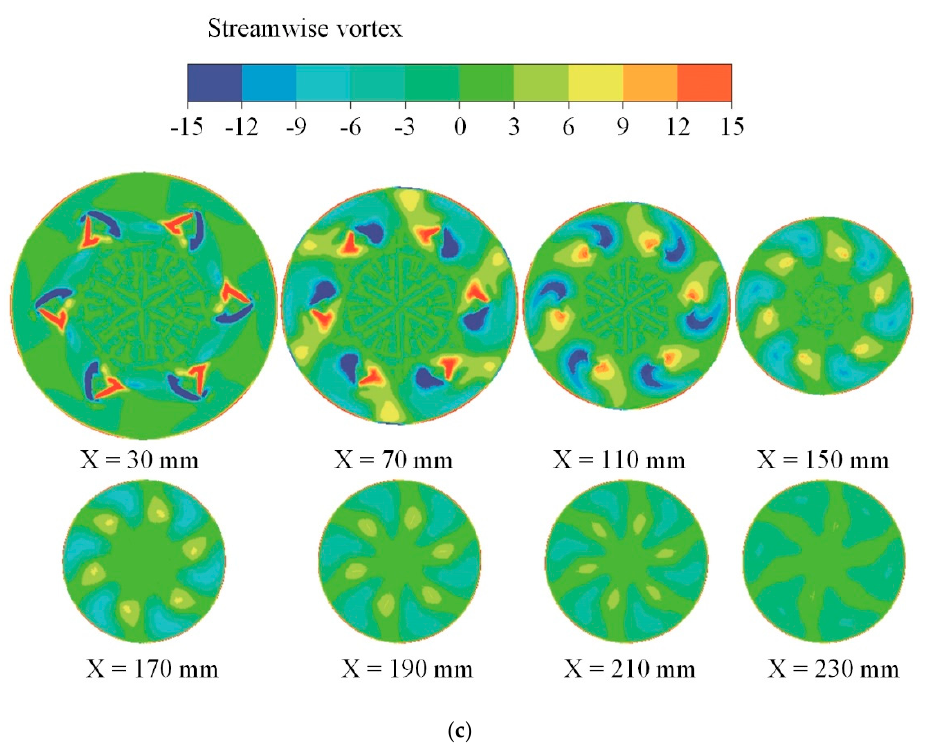
Figure 7. Streamwise vortex distribution. ( a ) Square nozzle; ( b ) Circular nozzle; ( c ) Triangle nozzle.